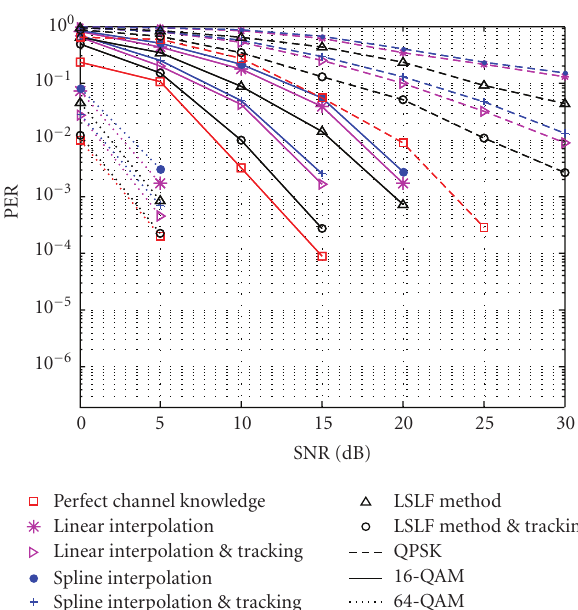
Figure 9: Throughput in Ped.B 6km/h without using channel